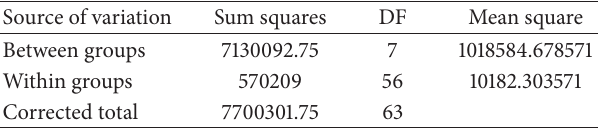
Table 2: One-way analysis of variance of differences between groups.